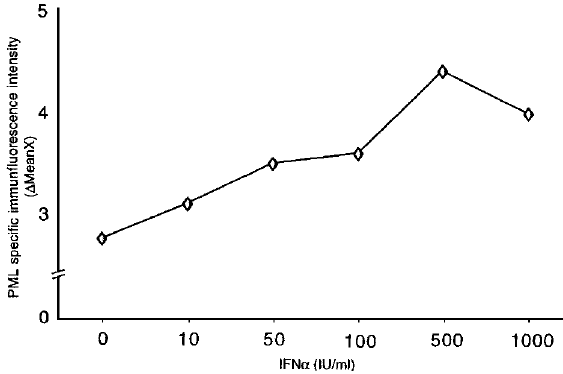
FIG. 5. Induction of PML protein by IFN- a in HL60 cells. HL60 cells were treated with (B) and without (A) IFN- a (1000IU/ml) for 18h. Expression of PML protein was analysed by flow cytometry using a specific monoclonal anti-PML antibody as descibed in Materials and Methods. Normal mouse IgG was used as isotype control.